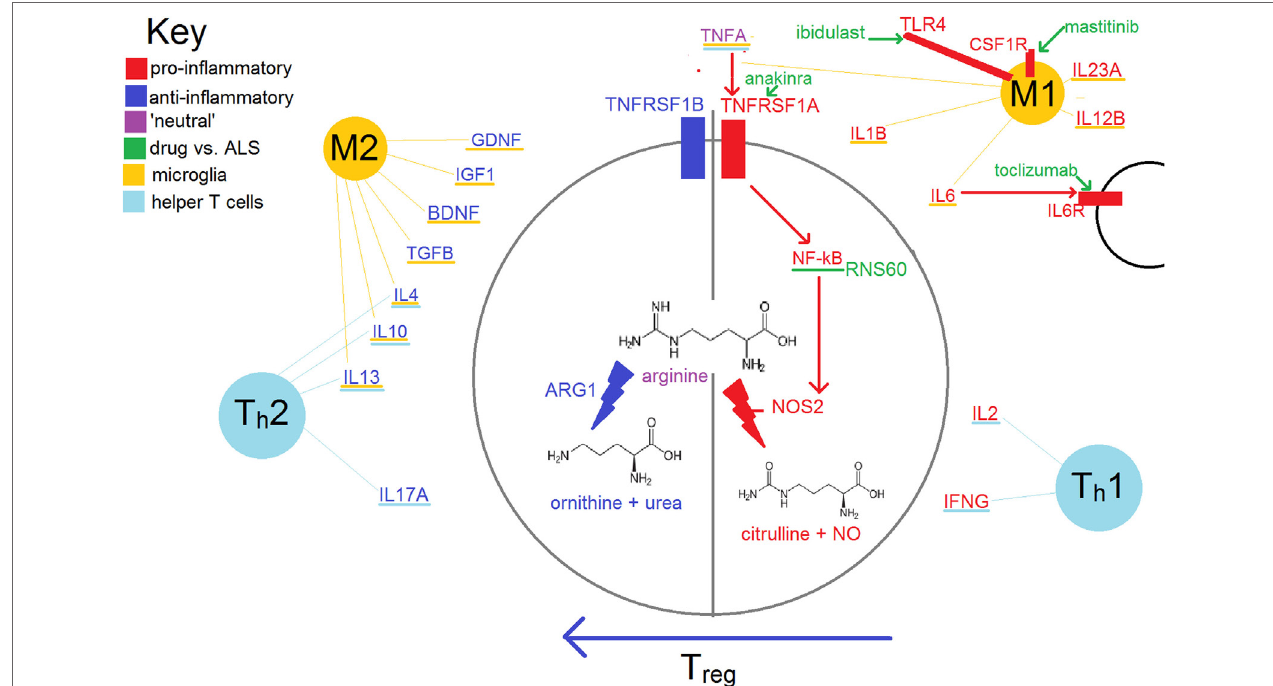
FigURe 1 | Simplified schema of inflammation in amyotrophic lateral sclerosis (ALS). Some of the treatments in this review with relatively ‘specific’ modes of action are also